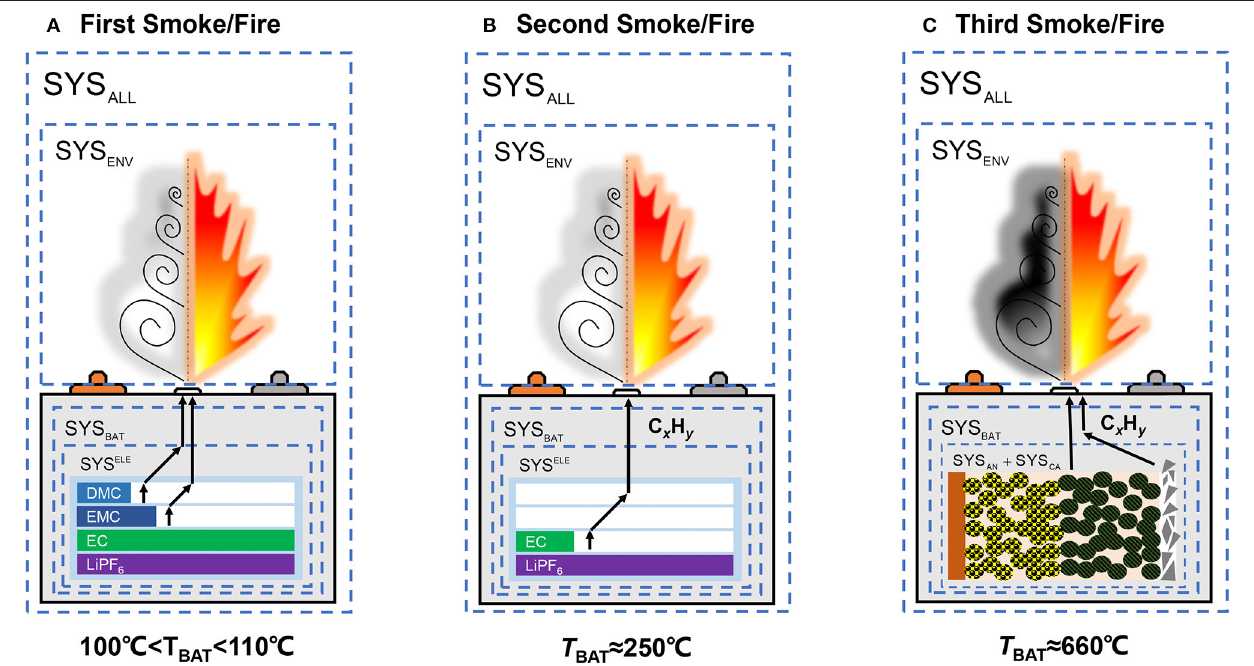
FIGURE 6 | Interpretation of the multi-stage smoke or jet fire during thermal runaway tests. (A) The first smoke/fire due to the gasification of DMC and EMC, the color of the smoke is white-gray; (B) The second smoke/fire due to the gasification of EC, the color of the smoke is white-gray; (C) The third smoke/fire due to the melting of aluminum collector and C x H y bursting out during thermal runaway. The smoke is black, if the aluminum collector is